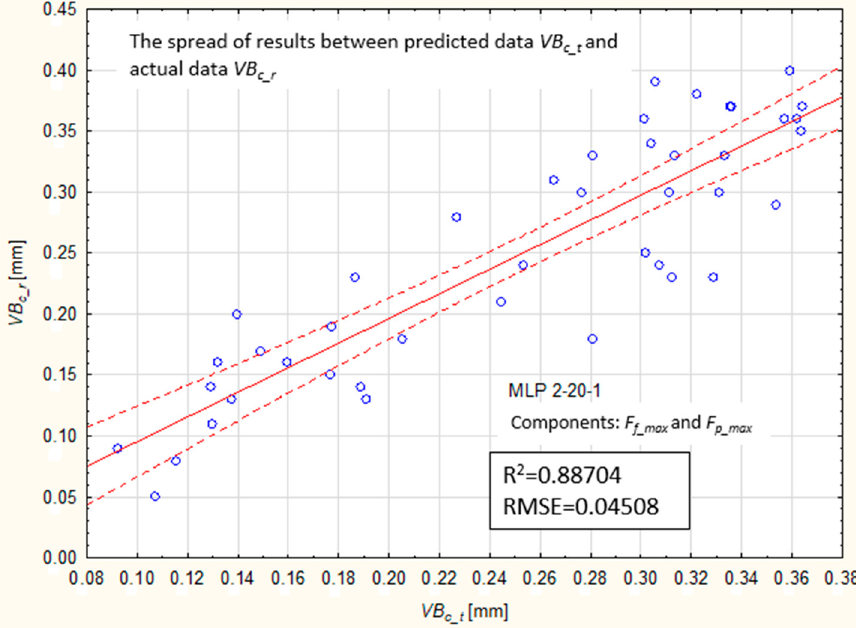
Figure 12. Comparison of predicted values, VBc_t, with experimental data, VBc_r, at validation stage (MLP 2-20-1).